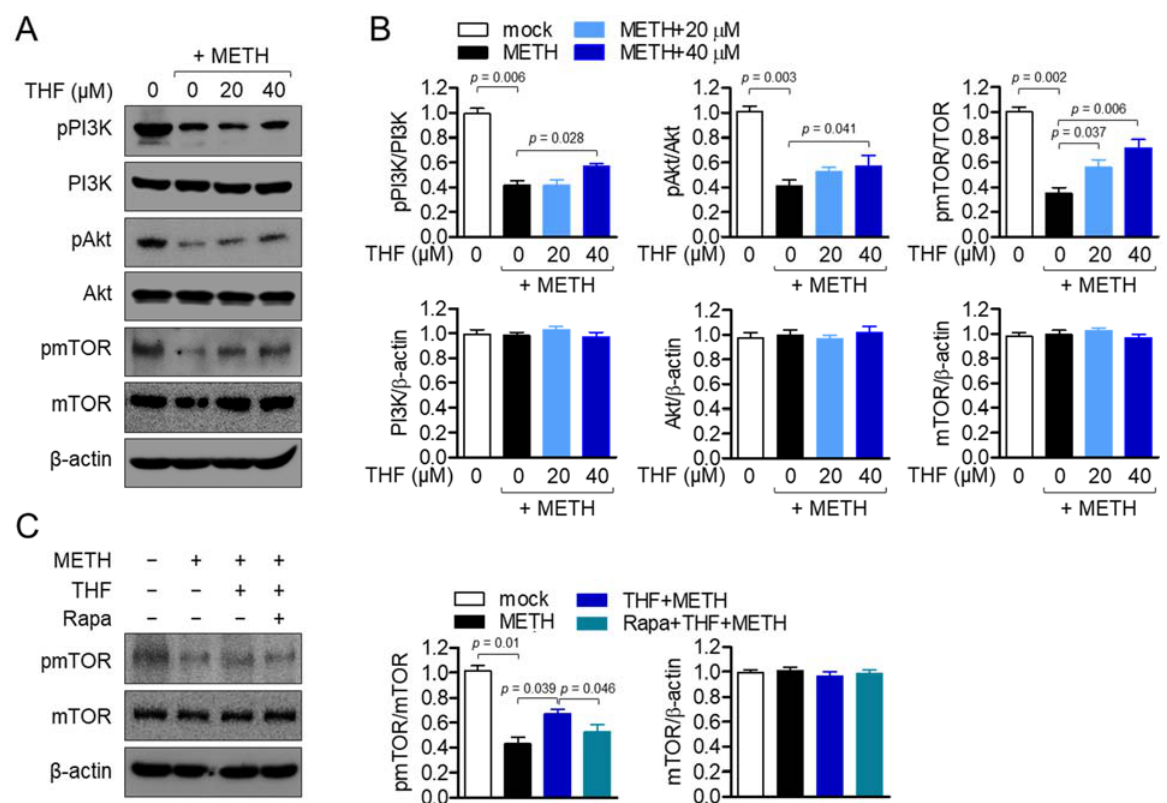
Figure 5. ( A ) SH-SY5y cells were pretreated with the indicated concentration of THF for 6 h and then exposed to 2 mM METH for an additional 1 h. The expression levels of phosphorylated phosphoinositide 3-kinase (PI3K), Akt, and mammalian target of rapamycin (mTOR) were detected by western blot analysis. ( B ) The phosphorylation levels were normalized to the level of total protein and total proteins were normalized with the level of β -actin. ( C ) SH-SY5y cells were pretreated with 50 µ M rapamycin for 1 h and then 40 µ M of THF for additional 1 h. Cells were exposed to 2 mM METH for 30 min for western blot. The level of phosphorylated mTOR, total mTOR and β -actin were detected and normalized with the loading control. Results are shown as the mean value of three experiments ± SEM. p value between two indicated groups.